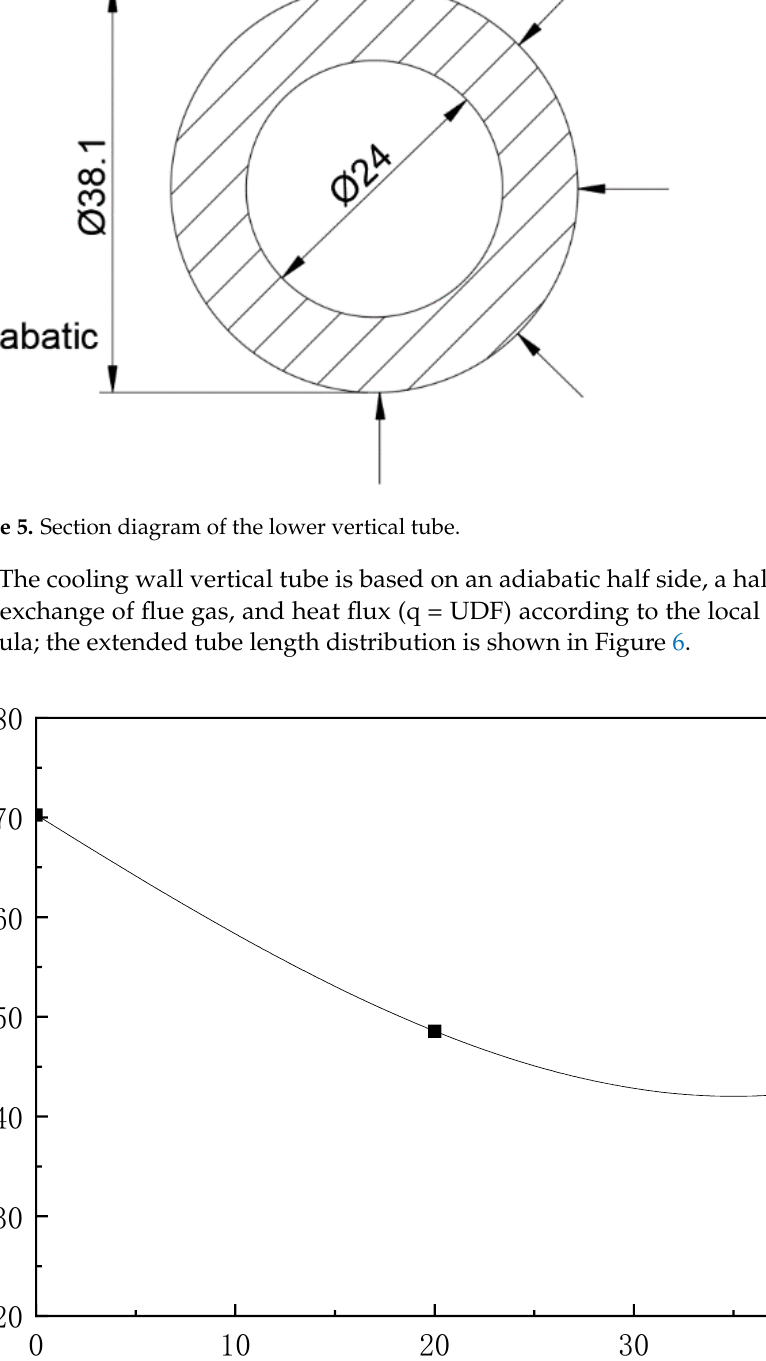
Figure 6. Heat flux of the cooling wall tube. 2.2. Meshing and Solution Setup The half side of the Y-tube is adiabatic, and the half side is subject to heat exchange from the flue gas; the heat flux is derived using Chen ’ s local conversion formula (expressed as q = UDF in the paper). The structured grid is generated in ICEM from the calculation domain, and the grid at the Y-type tee is refined; the axial grid density is sparse because the variation of the flow and heat transfer in the axial direction is not significant. The velocity inlet and pressure outlet are used, and the RNG k-epsilon turbulence model is applied. Compared with the k-epsilon standard model, the k-epsilon RNG turbulence model has a wider application and higher accuracy. The thermal physical parameters of supercritical CO 2 are obtained by retrieving NIST real-gas-model data in Fluent, the SIMPLEC algorithm is used for the pressure and velocity coupling, the QUICK discrete format is used for the momentum and energy equations, and the second-order windward format is used for the turbulent kinetic energy and turbulent dissipation equations.